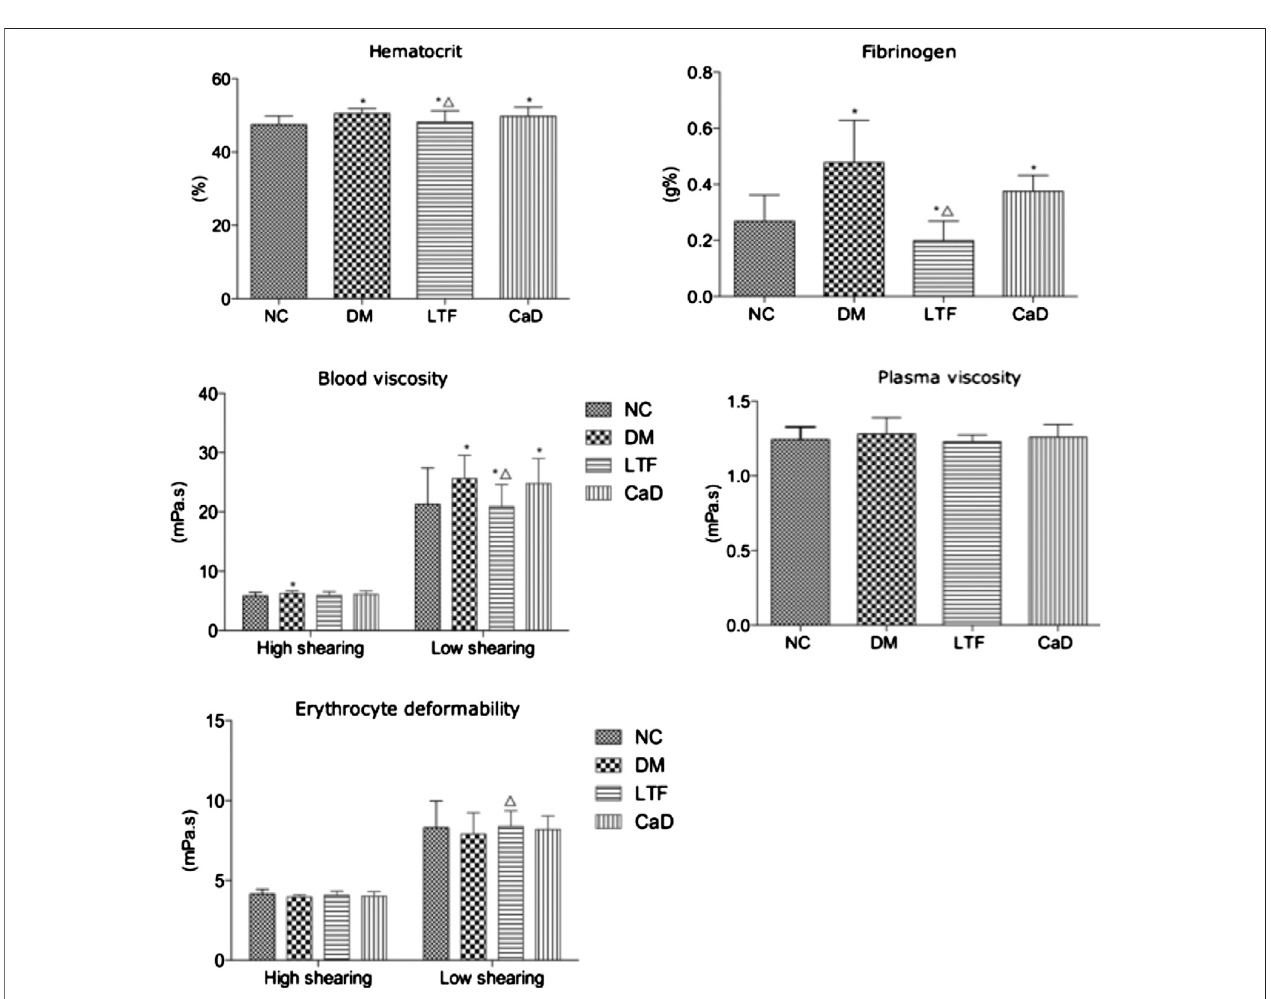
FIGURE 2 | Effects of LTF and CaD on hemorrheological indicators. Data are mean ± SD from six rats per group. (* p < 0.05: vs. NC group; △ p < 0.05: vs. DM group).